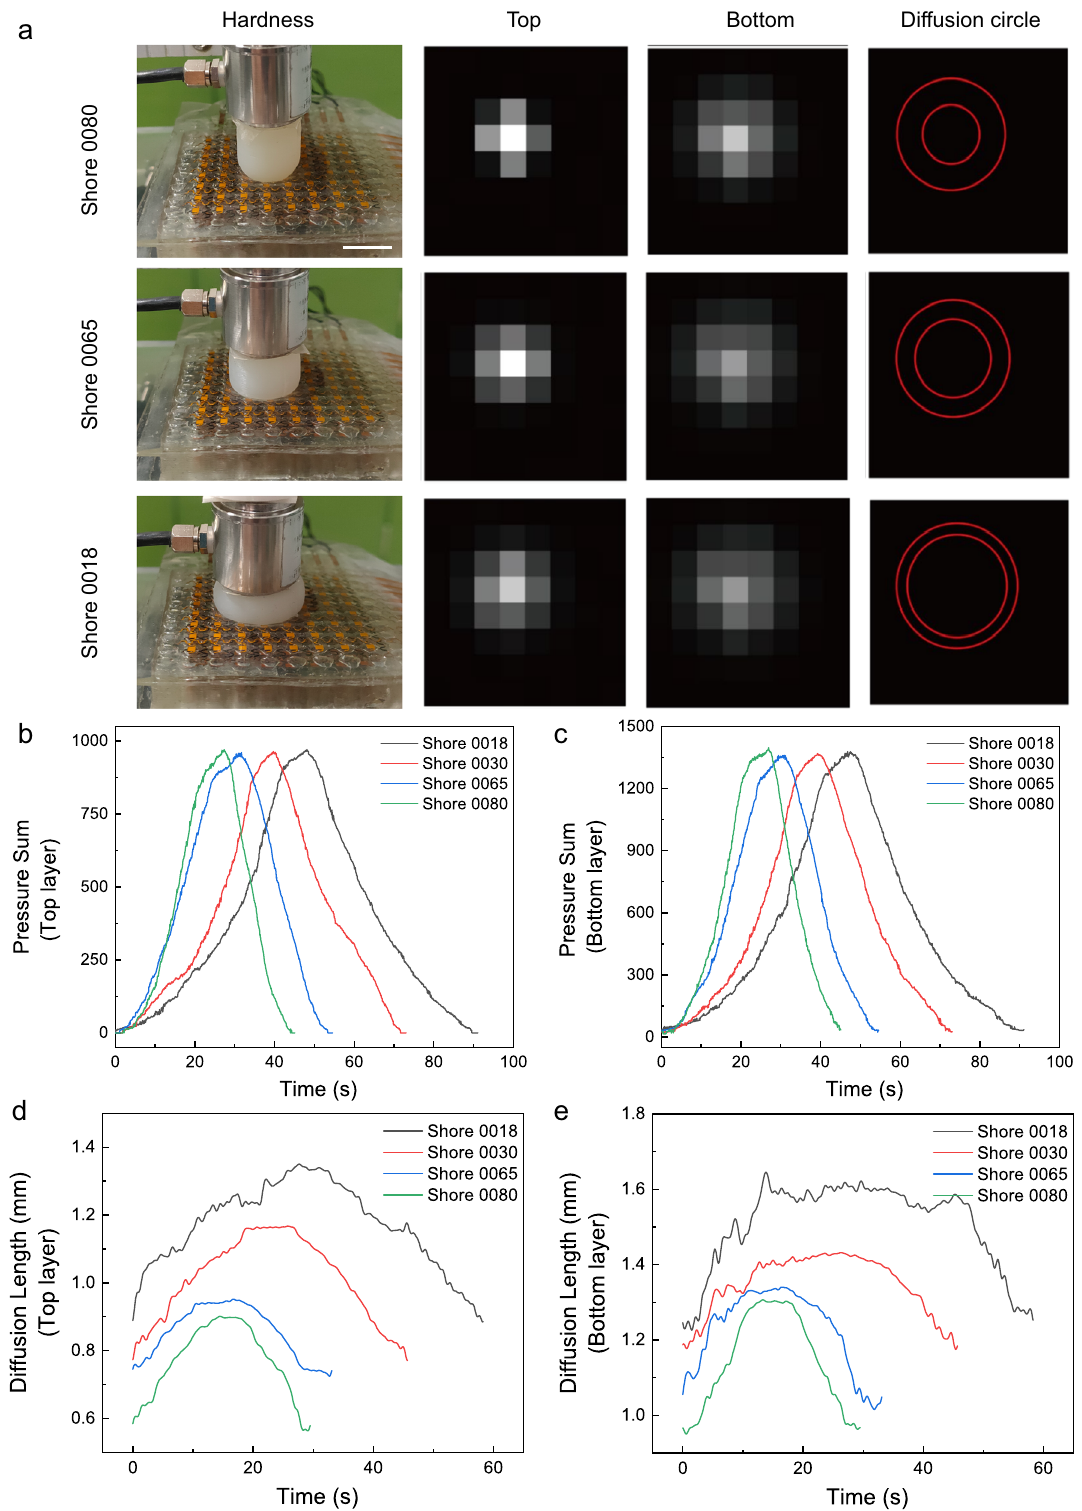
Fig. 4 Measurement of the hardness of an object. a Dynamic response of the BMRs when pressing on an object. The 1.5 cm radius hemispherical objects of different hardness are pressed at the same speed by the BMRs up to 5 N. The red circles indicate the diffusion length of each sensing layer. b , c Total pressure measured at top and bottom sensing layers for indenters of different hardness during the pressing process. d , e After pressure normalization, the relationship between total pressure value and diffusion length. Diffusion length at top and bottom sensing layers for indenters of different hardness during the pressing process. Scale bar: 1 cm ( a